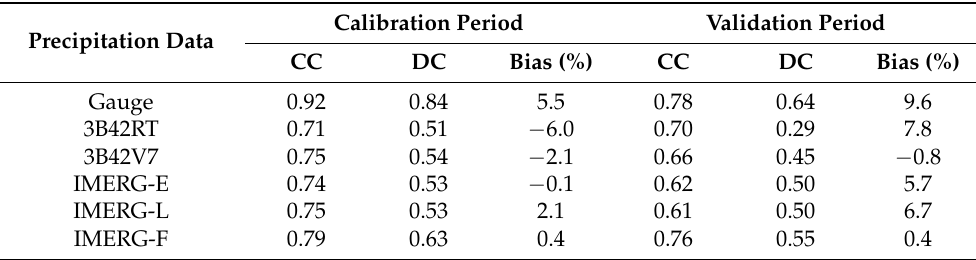
Table 2. Statistical results of the daily runoff during the calibration and validation periods driven by rain gauge observations and the five SPPs. Precipitation Data